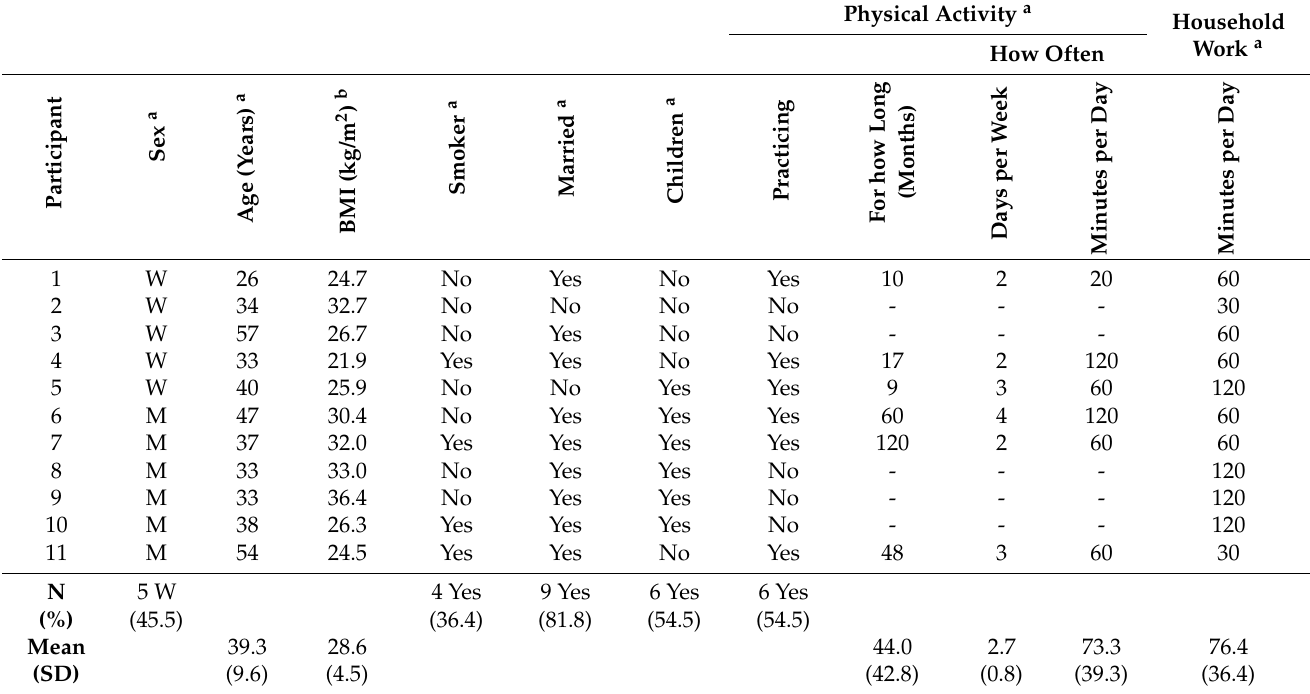
Table 1. Demographic and social characteristics of the sample; individual data and group summary statistics. Data collected